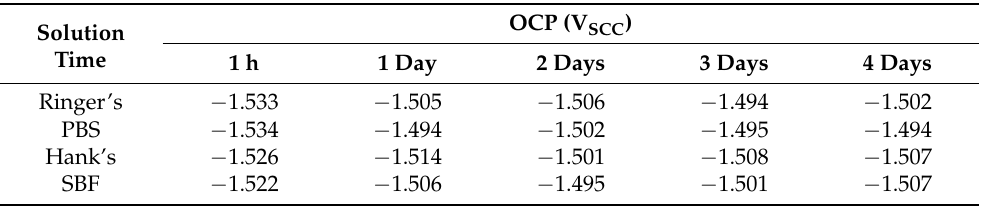
Table 4. Variation of OCP values as a function of immersion time for AZ31B specimens in Ringer’s, PBS, Hank’s, and SBF solutions.